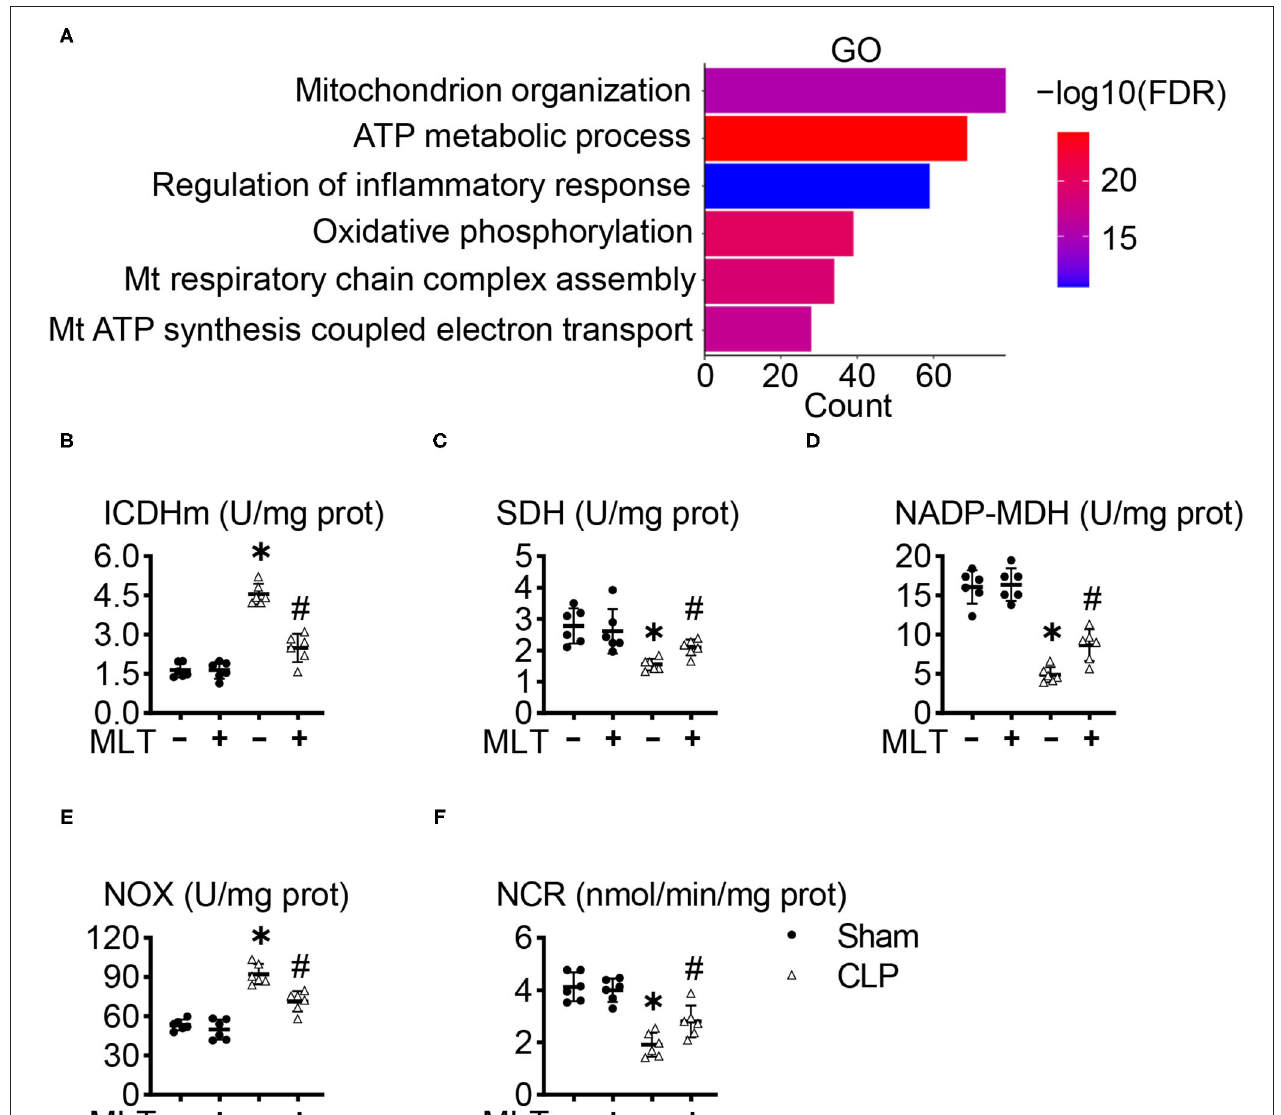
FIGURE 3 | Melatonin ameliorates mitochondrial dysfunction in sepsis-induced myocarditis. (A) Gene ontology (GO) enrichment for the regulated genes between the cecal ligation puncture (CLP) group and CLP + MLT group. The effects of MLT on the cardiac mitochondrial levels of mitochondrial isocitrate dehydrogenase (ICDHm) (B) , succinate dehydrogenase (SDH) (C) , malate dehydrogenase (MDH) (D) , NADH oxidase (NOX) (E) , and NADPH-cytochrome C reductase (NCR) (F) . Values are presented as means ± SD, *vs. sham, p < 0.05; # vs. CLP, p <